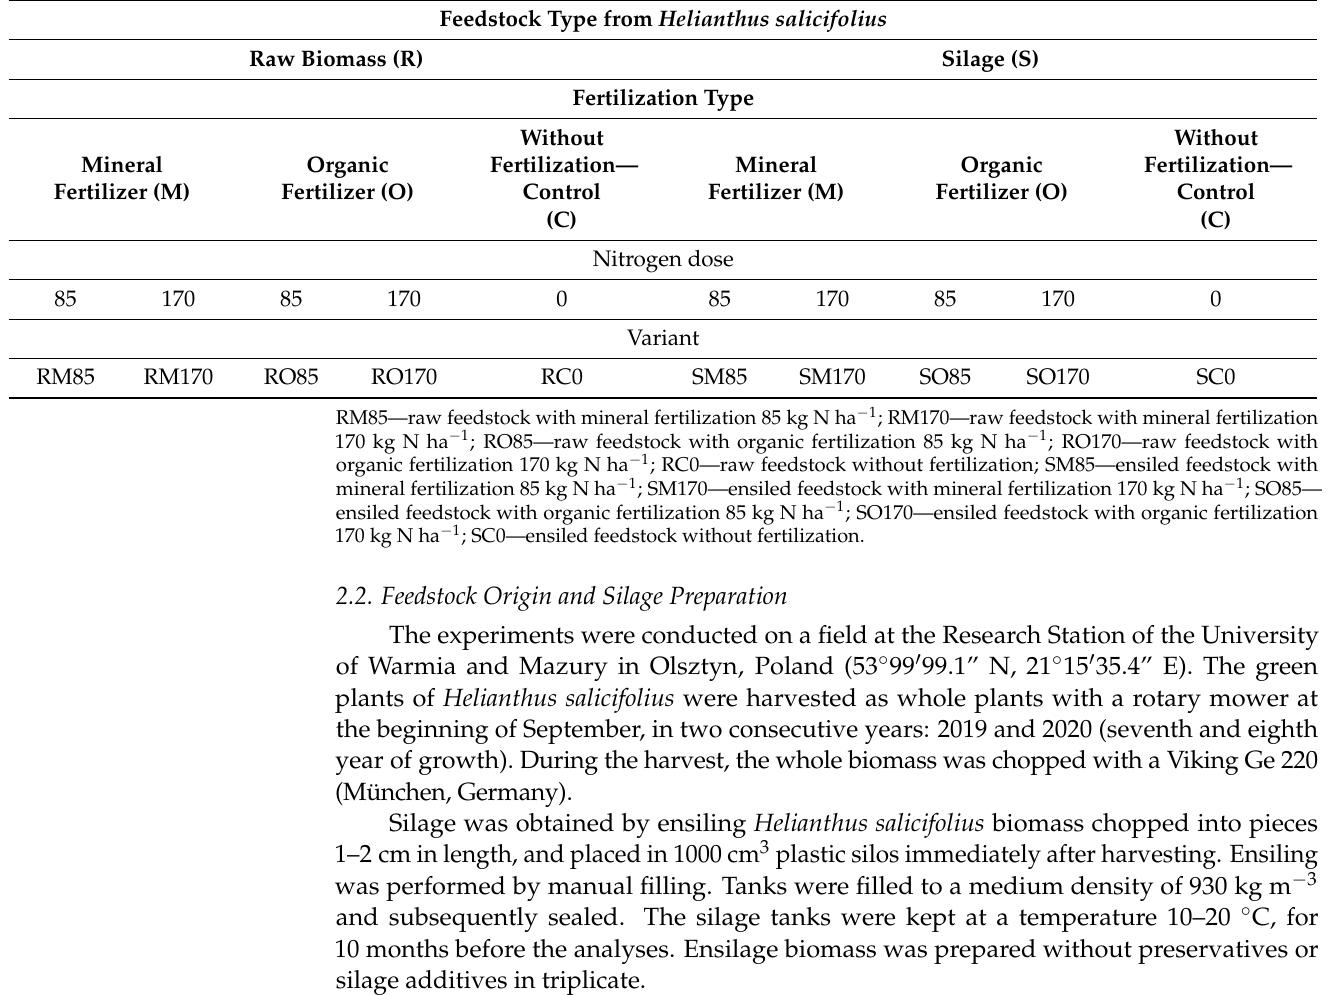
Table 1. The research